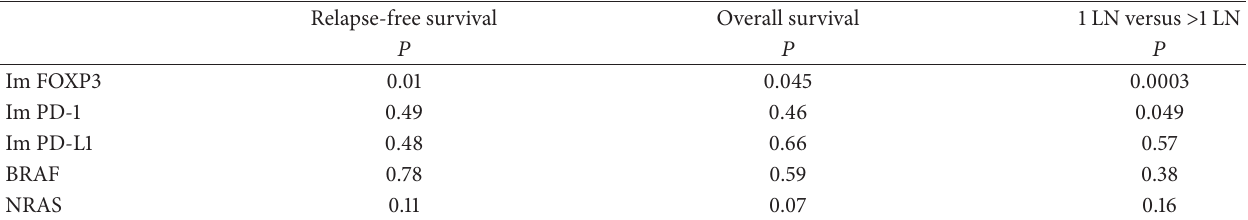
Table 5: Relationship between some predictive factors and the relapse-free survival, overall survival, and tumor burden. Relapse-free survival Overall survival 1 LN versus > 1